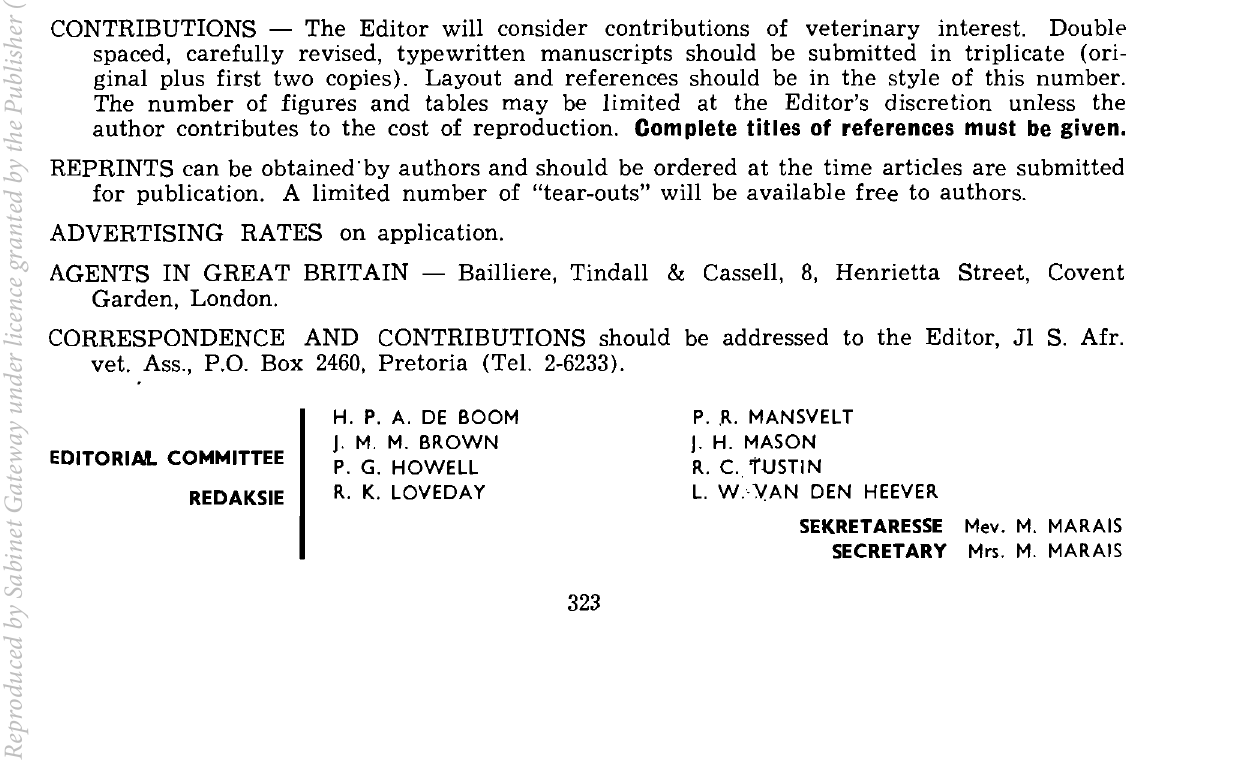
Fig. 1. Colon showing leucocytic infiltration of lamina propria and submucosa. 7S x Fig. 2. Higher magnification of colon showing primarily eosinophil infiltrate and crypts of Lieberkuhn distended with mucus. ISO x.